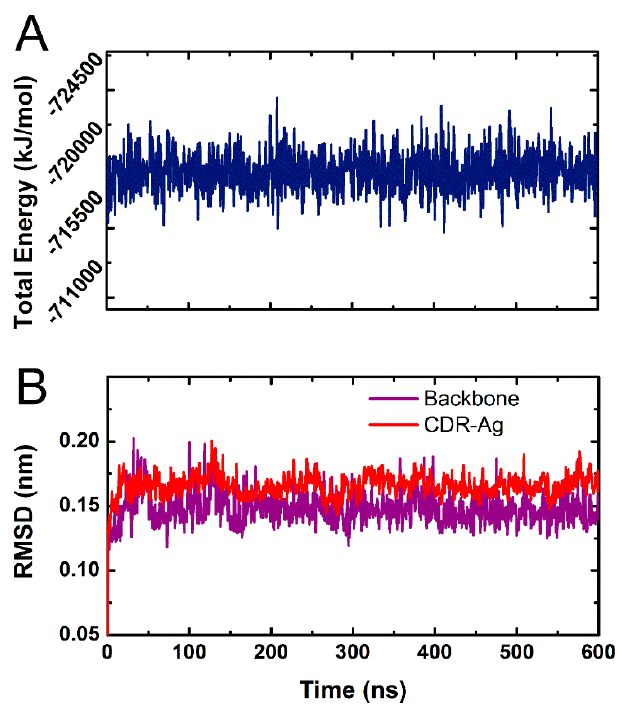
Figure 3. The total energy and root mean square deviations (RMSD) as functions of the Ab42-pCFH molecular dynamic (MD) simulation time. ( A ) the total energy of whole Ab42-pCFH structure; ( B ) the backbone RMSD of whole Ab42-pCFH structure labeled with puple color and the CDR-Ag RMSD of whole Ab42-pCFH structure labeled with red color.